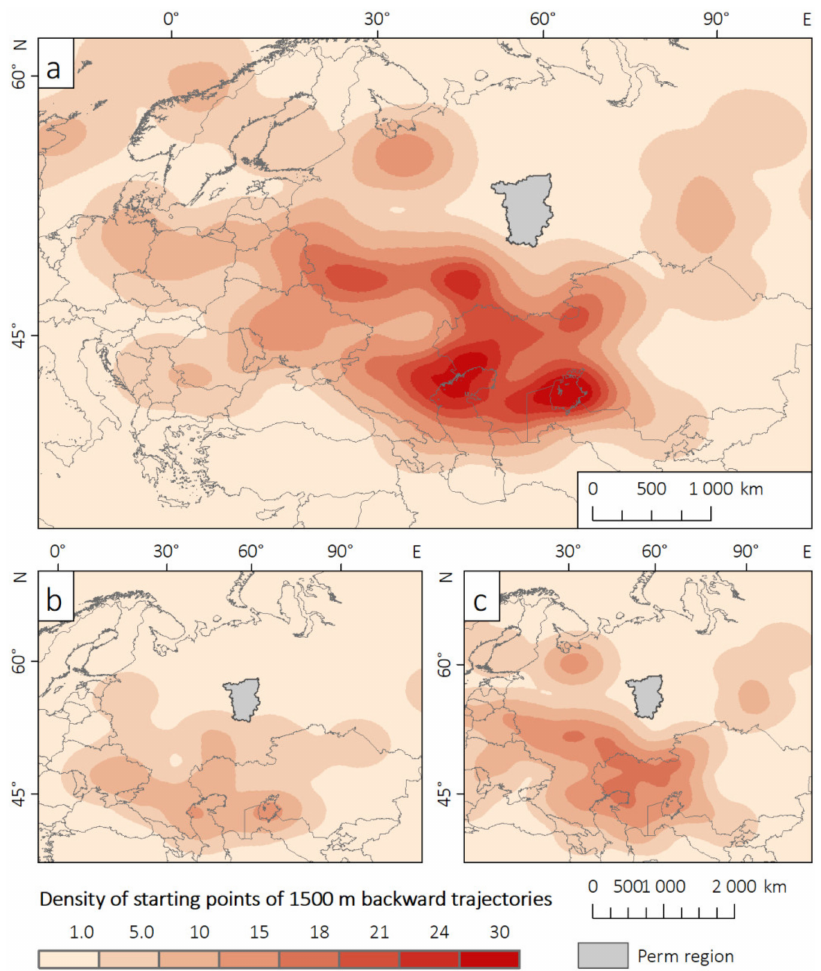
Figure 9. ( a ) Density of starting points of 72-h backward trajectories (at 1500 m ASL), for ( a ) SGE , ( b ) SGE WD , and ( c ) SGE ND